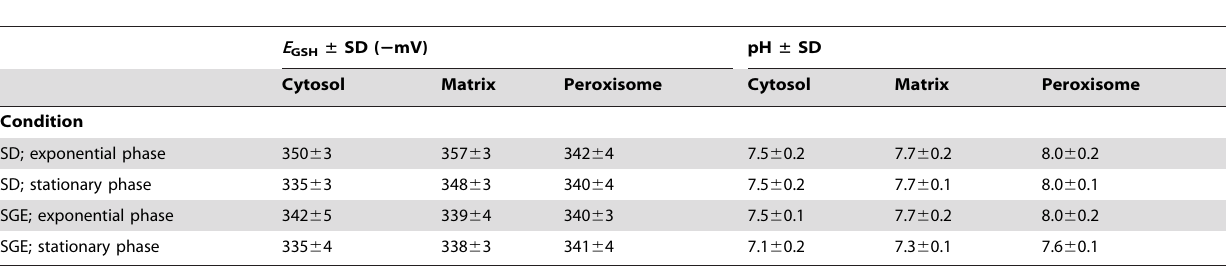
Table 1. E GSH and pH of wild type cells grown in fermentative (SD) and respiratory (SGE) medium in exponential and stationary